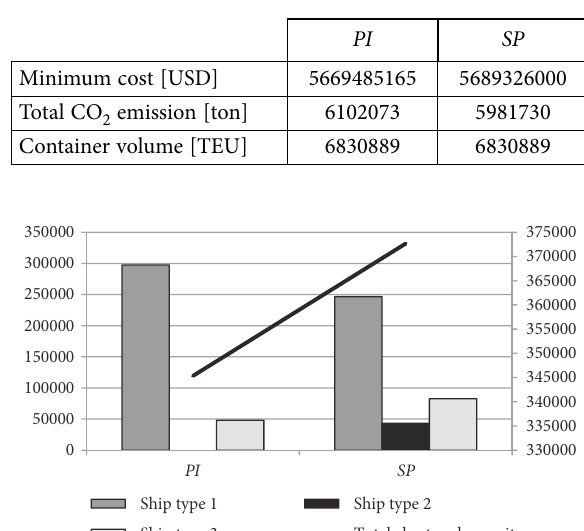
Table 8. Optimization results – under H Table 9. Optimization results – under